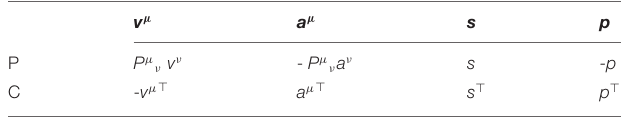
TABLE 1 | Transformation properties of the external fields under parity and charge conjugation.